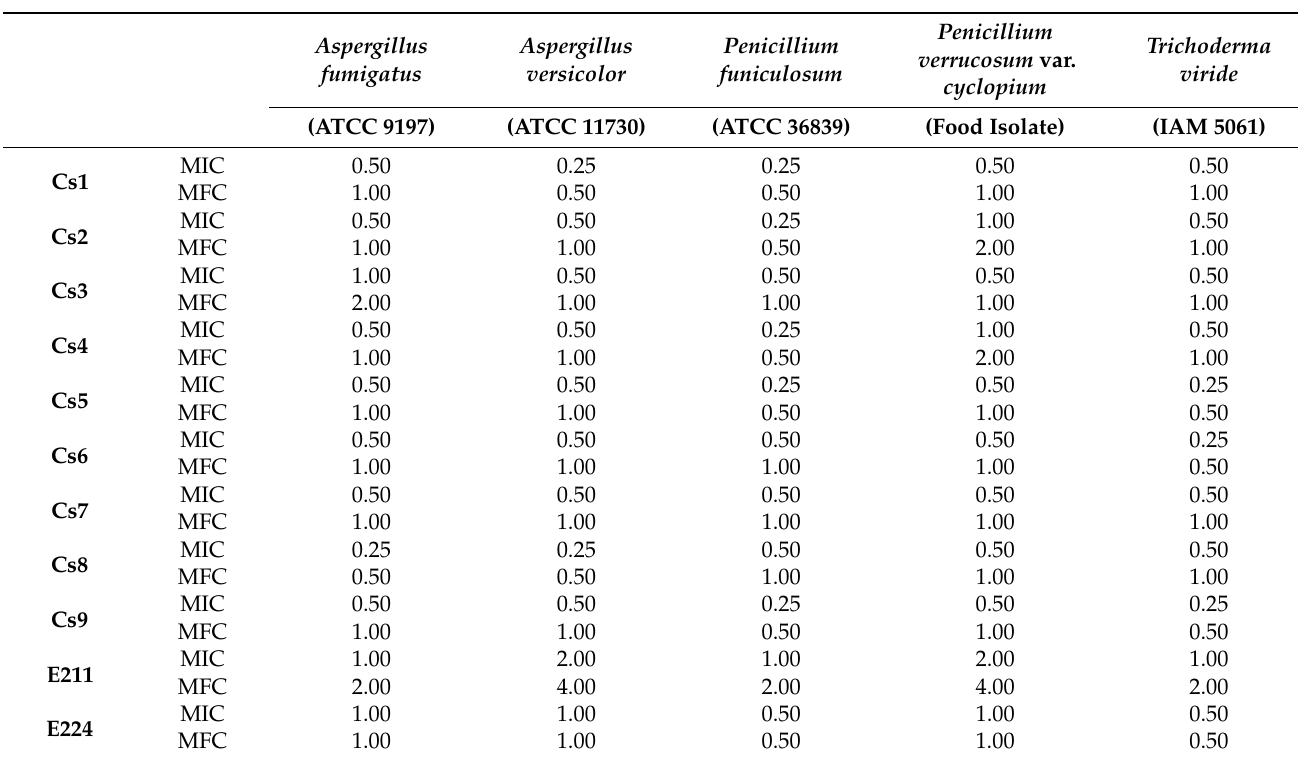
Table 5. Antifungal activity of C. spicatum extracts mg/mL. For positive controls, E211—sodium benzoate and E244—potassium metabisulfite were